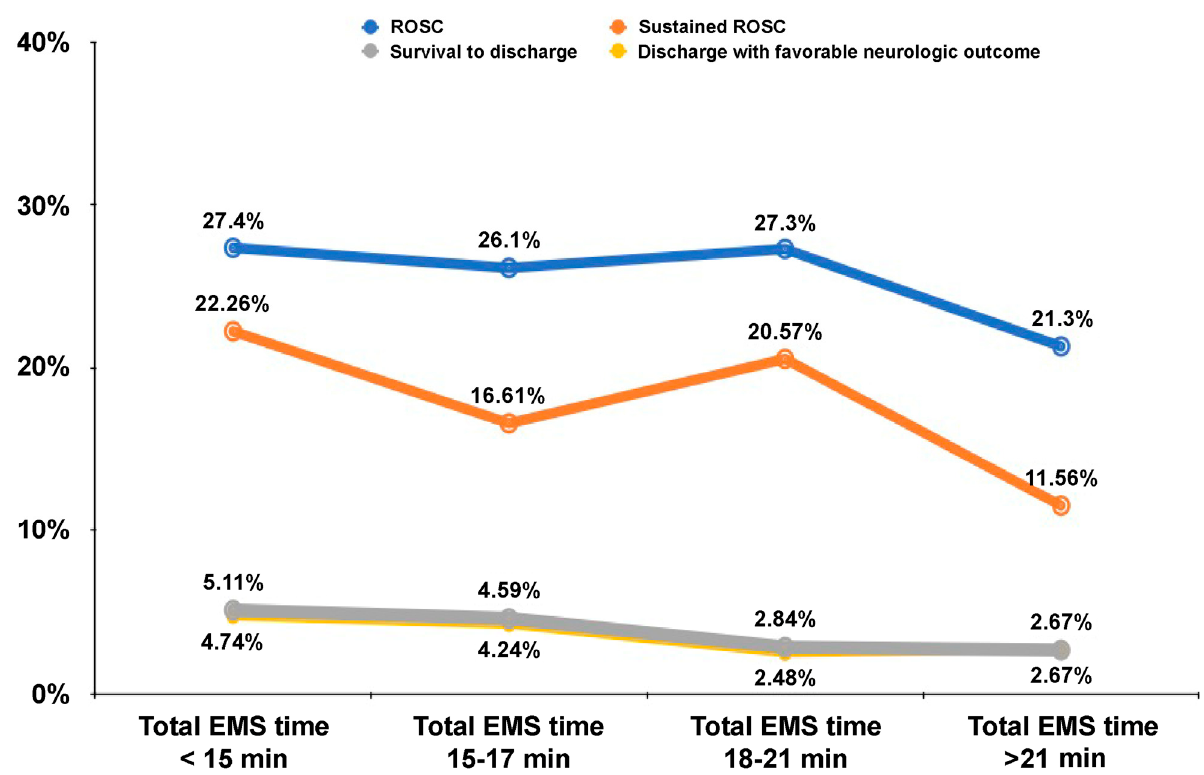
Figure 2. The impact of EMS rescue time on the primary and secondary outcomes.